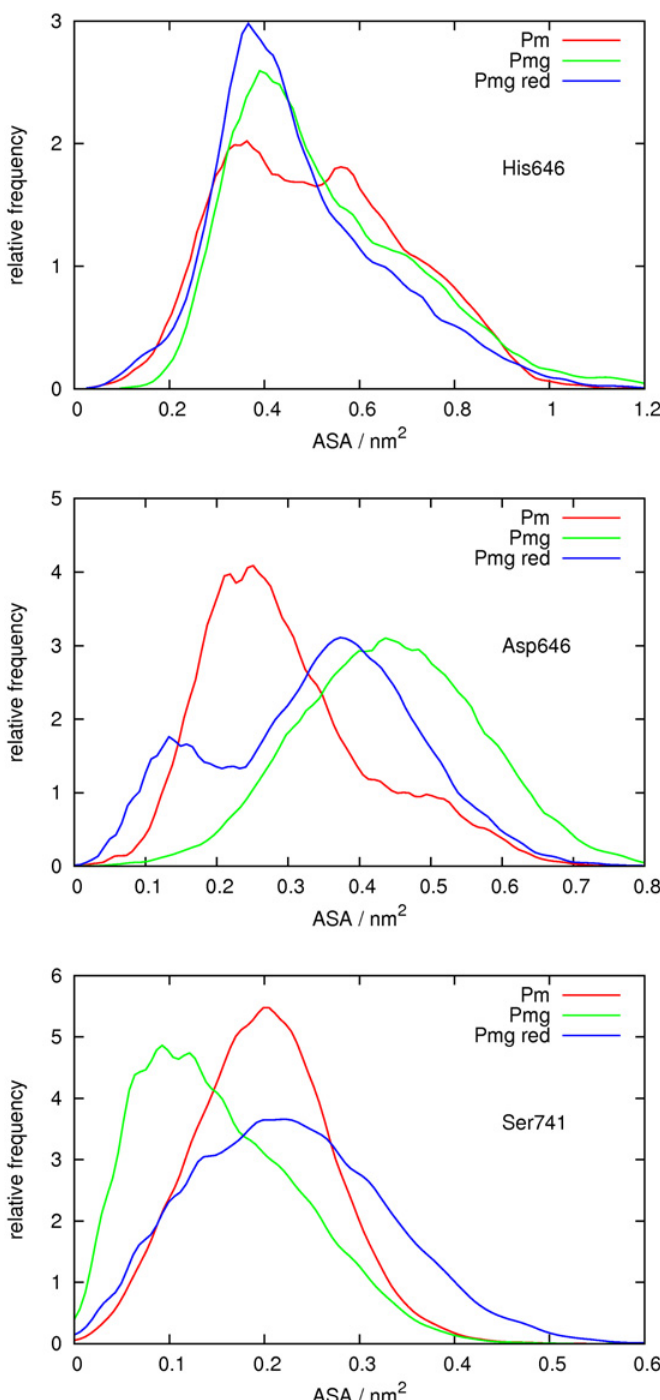
Fig 15. Distribution of solvent accessible surface area (ASA) of the catalytic triad. Frequency distributions of the ASA values of the side chains of His603 (top plot), Asp646 (middle plot) and Ser741 (bottom plot) obtained from the molecular dynamics simulations of plasmin (Pm) and of the catalytic domain of plasminogen in the native (Pmg) and reduced (Pmg red) forms. Each curve is normalized so that its integral is equal to